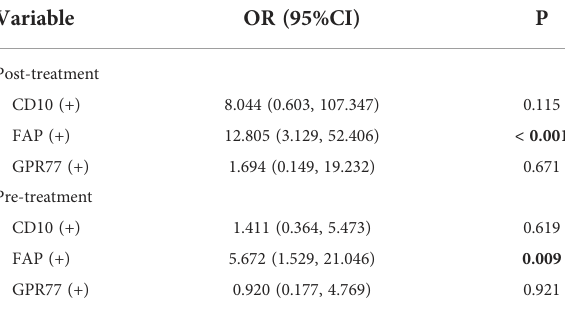
TABLE 3 Multivariable analysis for pathological response.